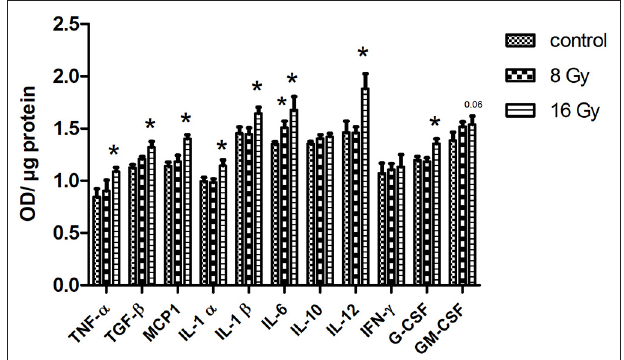
FIGURE 4 | The ELISA analysis of serum cytokines. The level of cytokines was measured in 100 µ g of serum in mice following 8 or 16Gy local heart radiation using ELISA ( t -test; * p < 0.05, mean with SEM, n = 5).